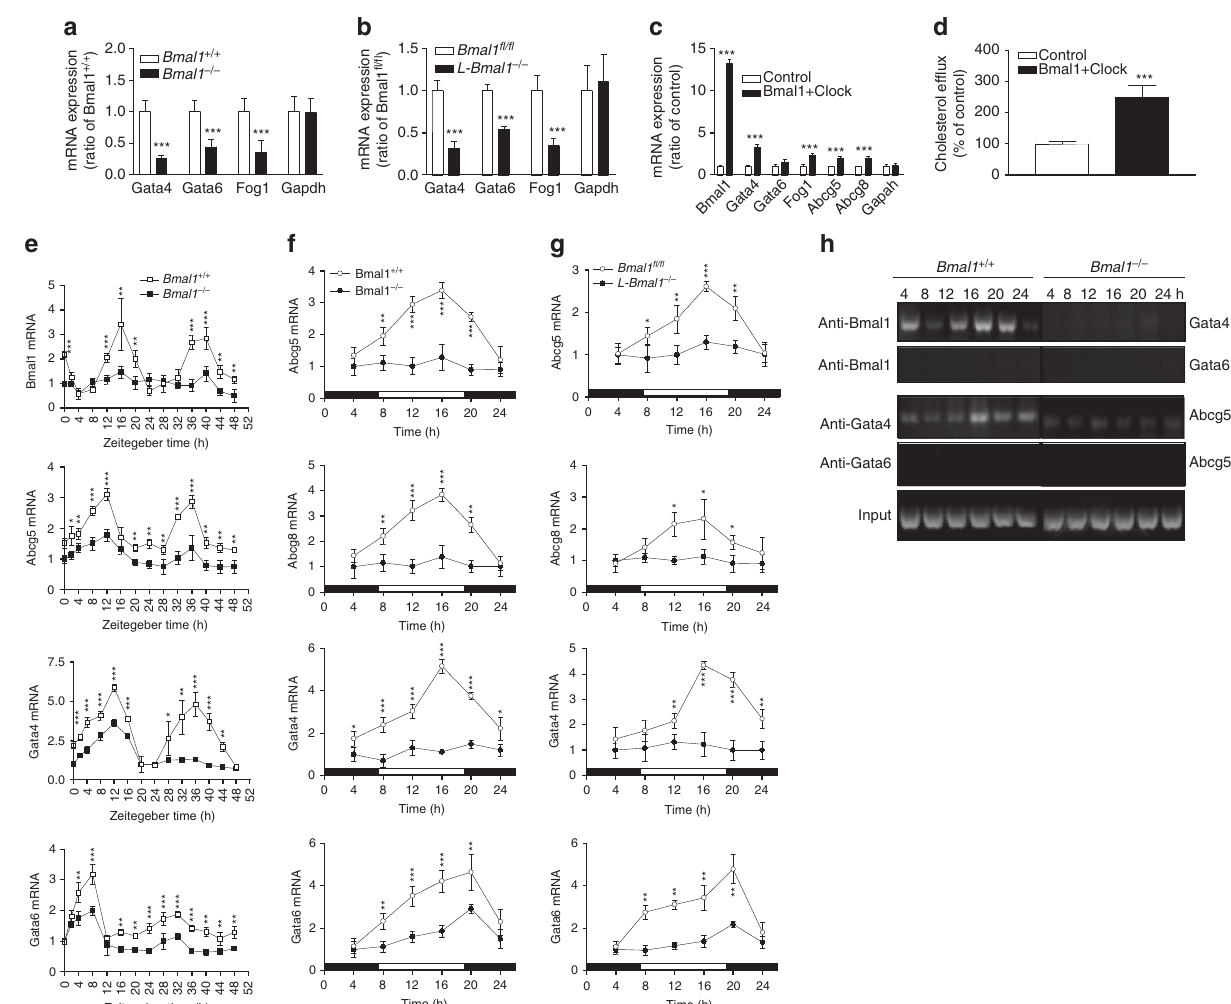
Figure 9 | Bmal1 regulates cholesterol transporters and Gata4 in wild-type mice. ( a , b ) Gene expression analysis in the livers of Bmal1 þ / þ , Bmal1 (cid:2) / (cid:2) ( a ), Bmal1 fl /fl and L-Bmal1 (cid:2) / (cid:2) mice ( b ). ( c , d ) Wild-type primary hepatocytes were transfected with plasmids expressing Bmal1 and Clock and used for gene expression studies ( c ) and for cholesterol efflux to bile acid acceptors ( d ). ( e ) Primary hepatocytes from Bmal1 þ / þ and Bmal1 (cid:2) / (cid:2) mice were treated with 50% serum for 2h and collected at indicated times to measure changes in gene expression. ( f , g ) Livers from Bmal1 þ / þ , Bmal1 (cid:2) / (cid:2) ( f ), Bmal1 fl / fl and L-Bmal1 (cid:2) / (cid:2) mice ( g ) (six mice for each time point) were collected at indicated times to measure mRNA levels of different genes. ( h ) ChIP analysis for the binding of Bmal1 to the Gata4 and Gata6 promoters, and for the binding of Gata4 and Gata6 to the Abcg5 promoter. Data in a – d were evaluated using the unpaired Student’s t -test. Data in e – g were examined by two-way ANOVA. Values are mean ± s.d. * P o 0.05, ** P o 0.01 and *** P o 0.001. Error bars represent